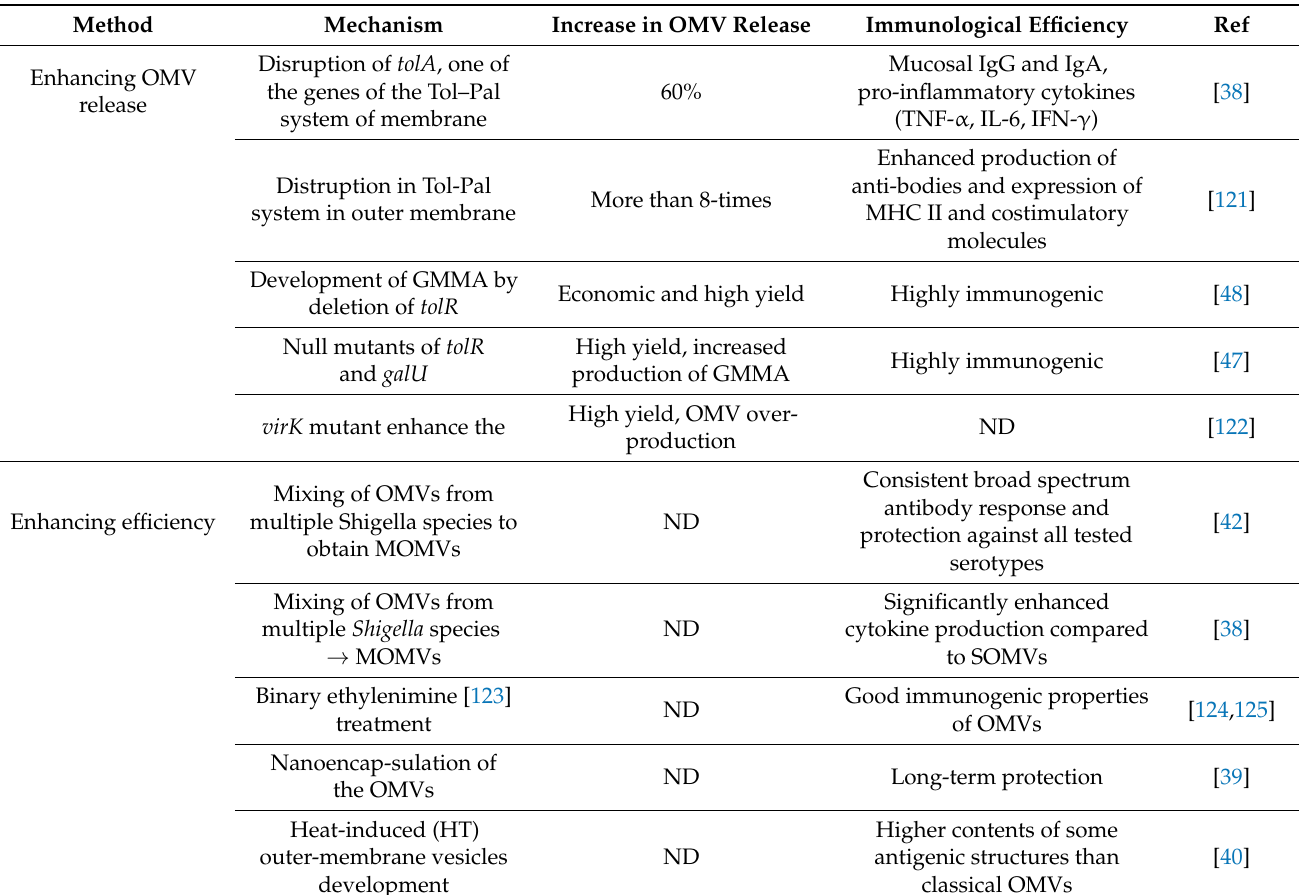
Table 4. Methods for enhancing the release, the immunological efficiency and the safety of Shigella